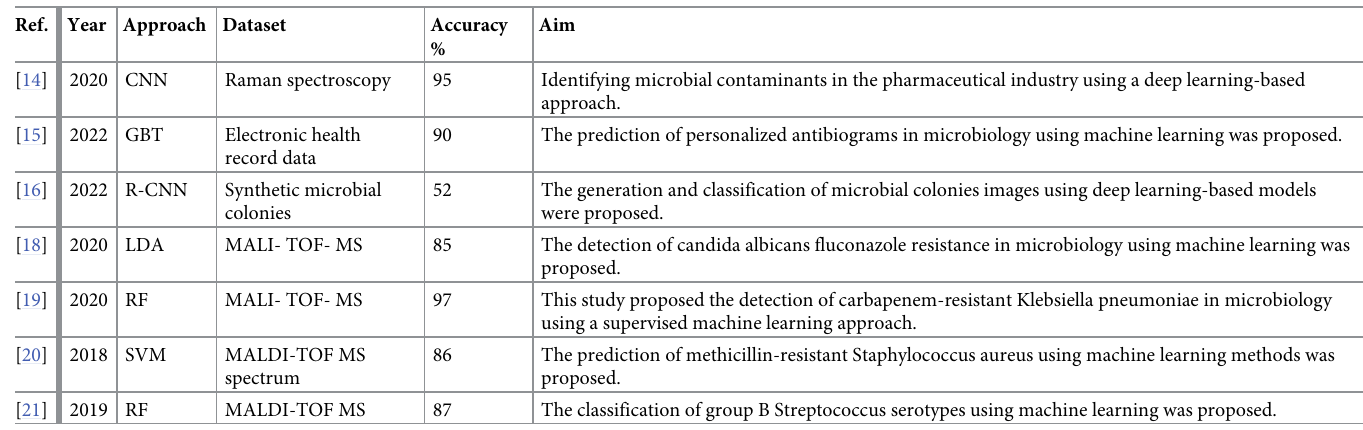
Table 1. The analysis of related literature in the context of predicting the microbe organisms. Ref. Year Approach Dataset